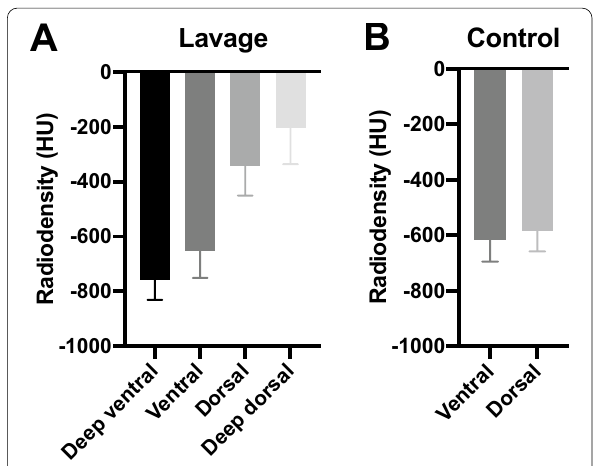
Fig. 5 CT HU values of lavage induced and control pigs. The HU values increased toward the deep dorsal parts on the sick pigs and remained on the same level for the control animals on both ventral and dorsal segments